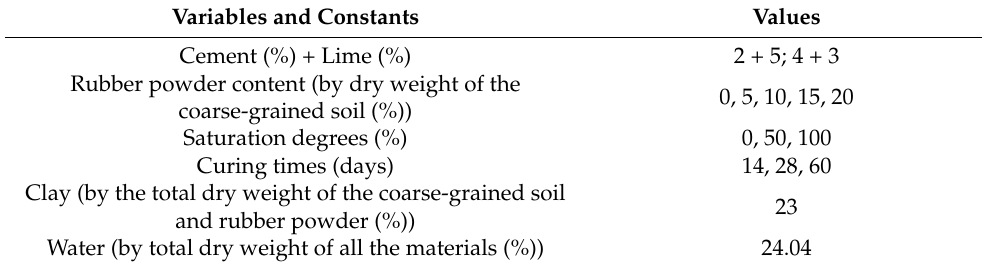
0, 5, 10, 15, 20 23